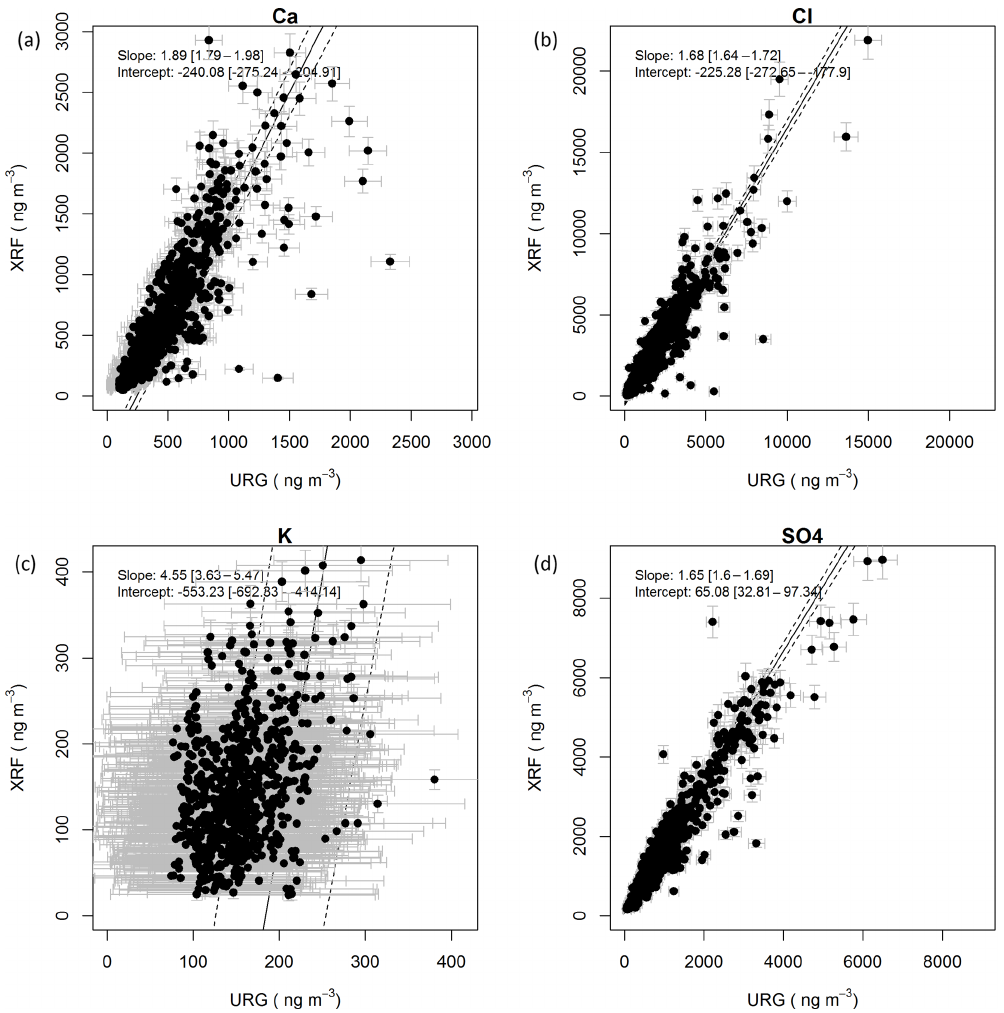
Figure 6. Deming regression of water soluble Ca (a) , Cl (b) , K (c) and SO 4 (d) as measured by URG and Ca, Cl, K and calculated SO 4 (from elemental S) measured by XACT (ngm − 3 ) at Marylebone Road,